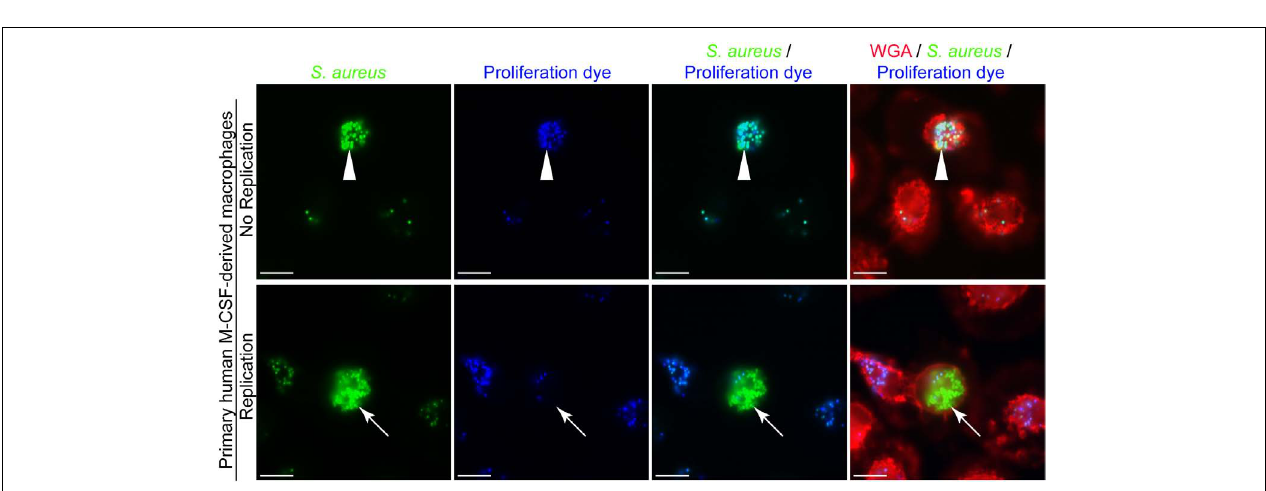
FIGURE 3 | Heterogeneity in the number of intracellular bacteria occurs in primary human M-CSF-derived macrophages. Primary human M-CSF-derived macrophages derived from an otherwise healthy donor were infected with S. aureus after 7 days of differentiation. Macrophages are marked with TMR-WGA (in red) while S. aureus USA300 is expressing GFP (in green). At the outset of the infection bacteria were co-labeled with eFluor TM -670 proliferation dye (pseudo-colored blue). These representative images were taken at 12 h post-infection and represent common events from multiple ( > 6) independent experiments. The white arrow head points to a primary phagocyte containing many cocci while the surrounding cells contain few. These bacteria are also marked with eFluor TM -670 proliferation dye at this time-point. White arrows point to a phagocyte that contains many GFP-positive cocci that are eFluor TM -negative indicating these bacteria have replicated. In contrast the surrounding cells contain few GFP-positive cocci that are also eFluor TM -670-positive. Scale bar is ∼ 10 µ